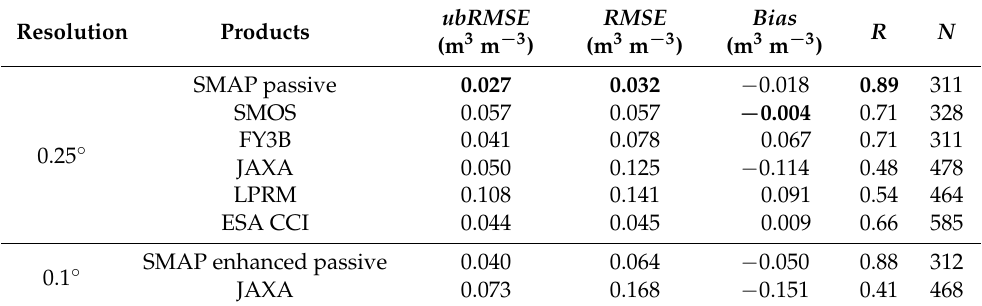
Table 1. Comparison of the Soil Moisture Active Passive (SMAP) passive, Soil Moisture and